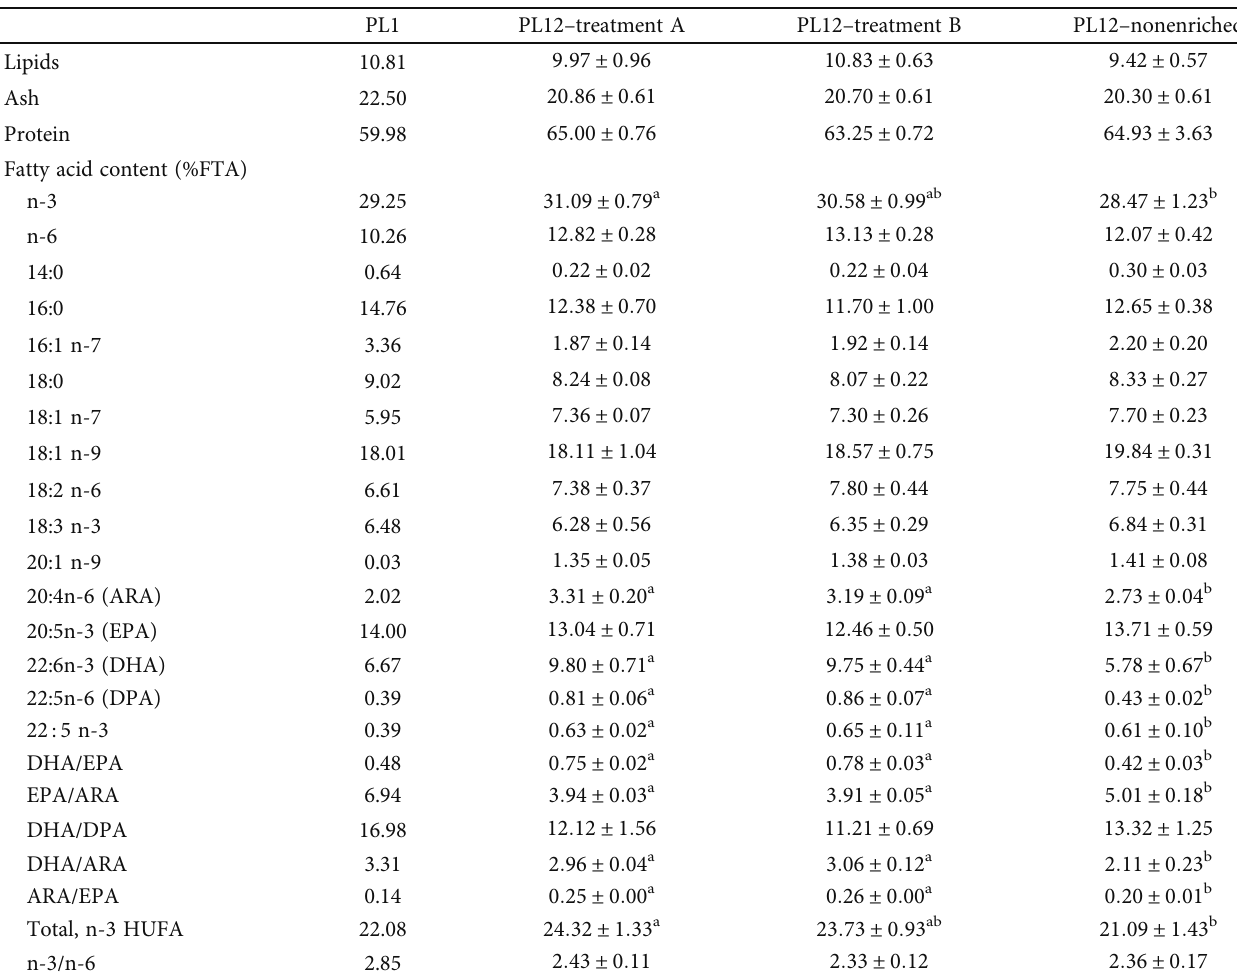
Table 5: Proximate (lipid, ash, and protein content (%dry matter)) and fatty acid composition (%TFA) of P. vannamei postlarvae 1 (PL1) and 12 (PL12) fed enriched Artemia with di ff erent experimental emulsions and unenriched Artemia . Lipid contents and FA data represent means ± SD ( n = 3 ). Di ff erent superscripts within each row indicate a signi fi cant di ff erence between diets (ANOVA ( P ≤ 0 : 05 ), Tukey ’ s HSD). PL1